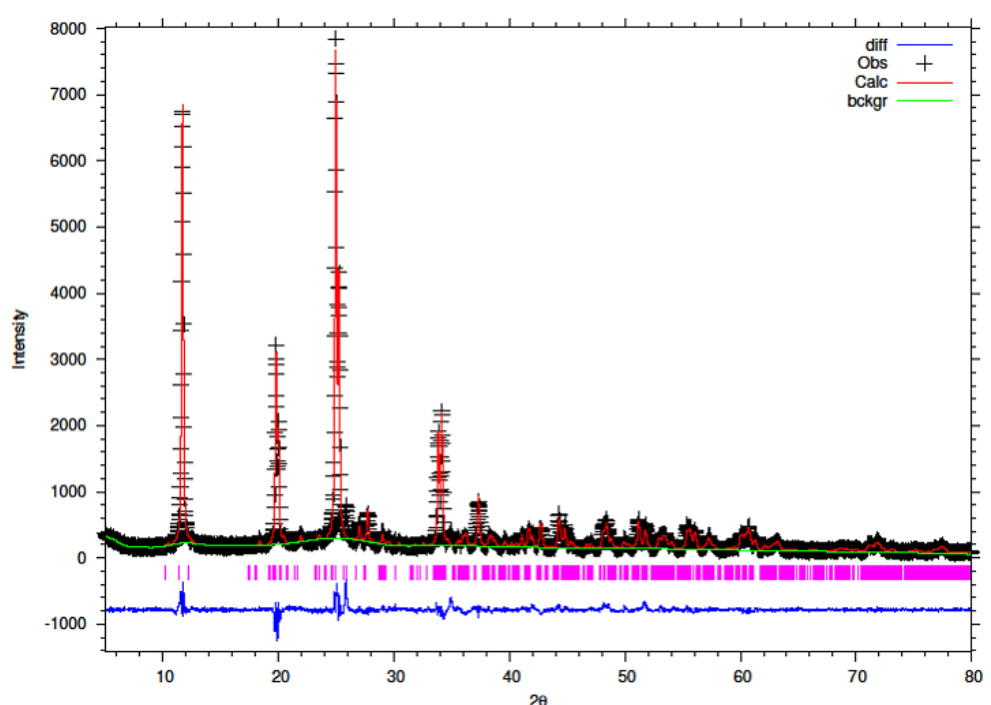
Table 5. Refined fractional atomic coordinates and isotropic thermal displacement parameters for conventionally refluxed 15% Y–ZrP.